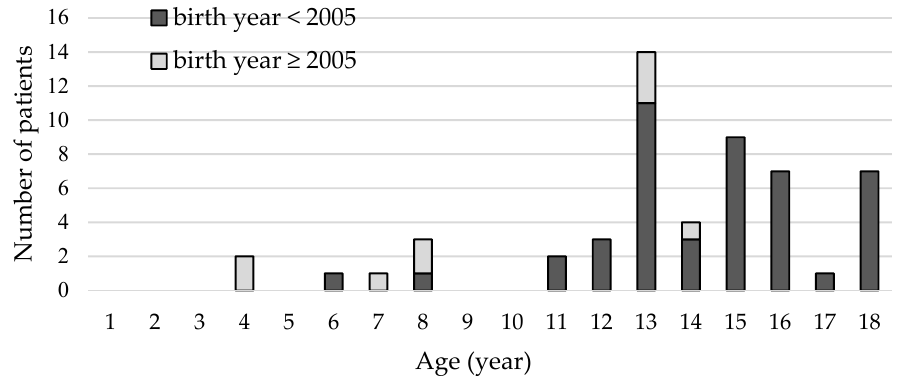
Figure 3. Distribution of age at onset of herpes zoster with complications.